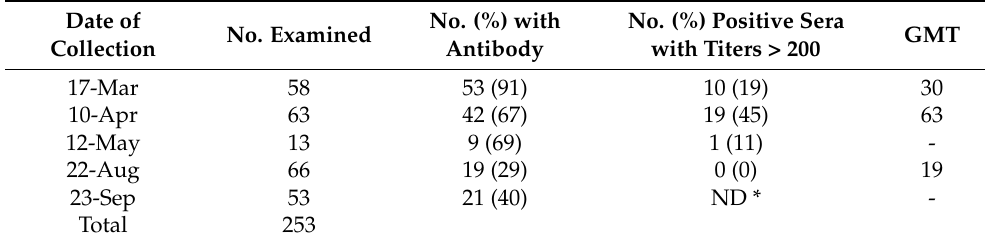
Table 3. Frequency of neutralizing antibodies to KKV in adult free-tailed bats in different months of the year, 1973. * Not Done. GMT = geometric mean titer.